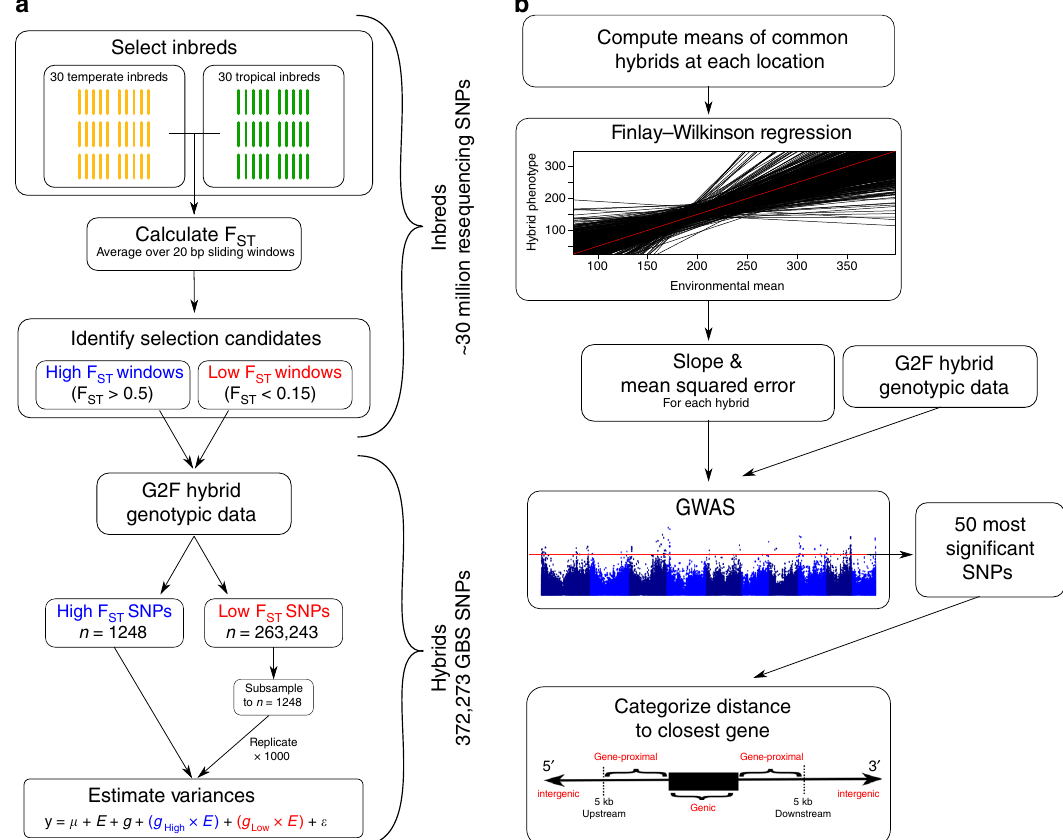
Fig. 1 Flowchart of experimental analyses. To investigate how putatively selected regions in fl uence variation for G × E ( a ), 30 temperate and 30 tropical inbreds were used to calculate F ST in 20 base pair sliding windows across the genome. Windows with mean F ST > 0.5 were categorized as “ high ” F ST , and windows with mean F ST < 0.15 were categorized as “ low ” F ST . SNPs from the Maize G × E project hybrids that were within high or low F ST windows were categorized as high or low F ST SNPs, and used to estimate G × E variances attributable to high and low F ST regions of the genome. To investigate location of variants associated with G × E ( b ), hybrid phenotypes were regressed on the means of common hybrids at each location. The slope and mean squared errors from each hybrid ’ s regression were used as response variables in GWAS, and the 50 most signi fi cant SNPs from each GWAS were evaluated for their position relative to the nearest